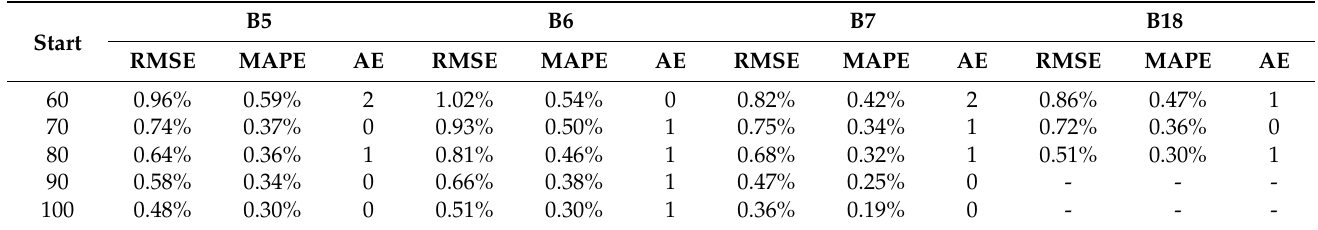
Table 6. Comparison of the prediction performance with different amounts of training